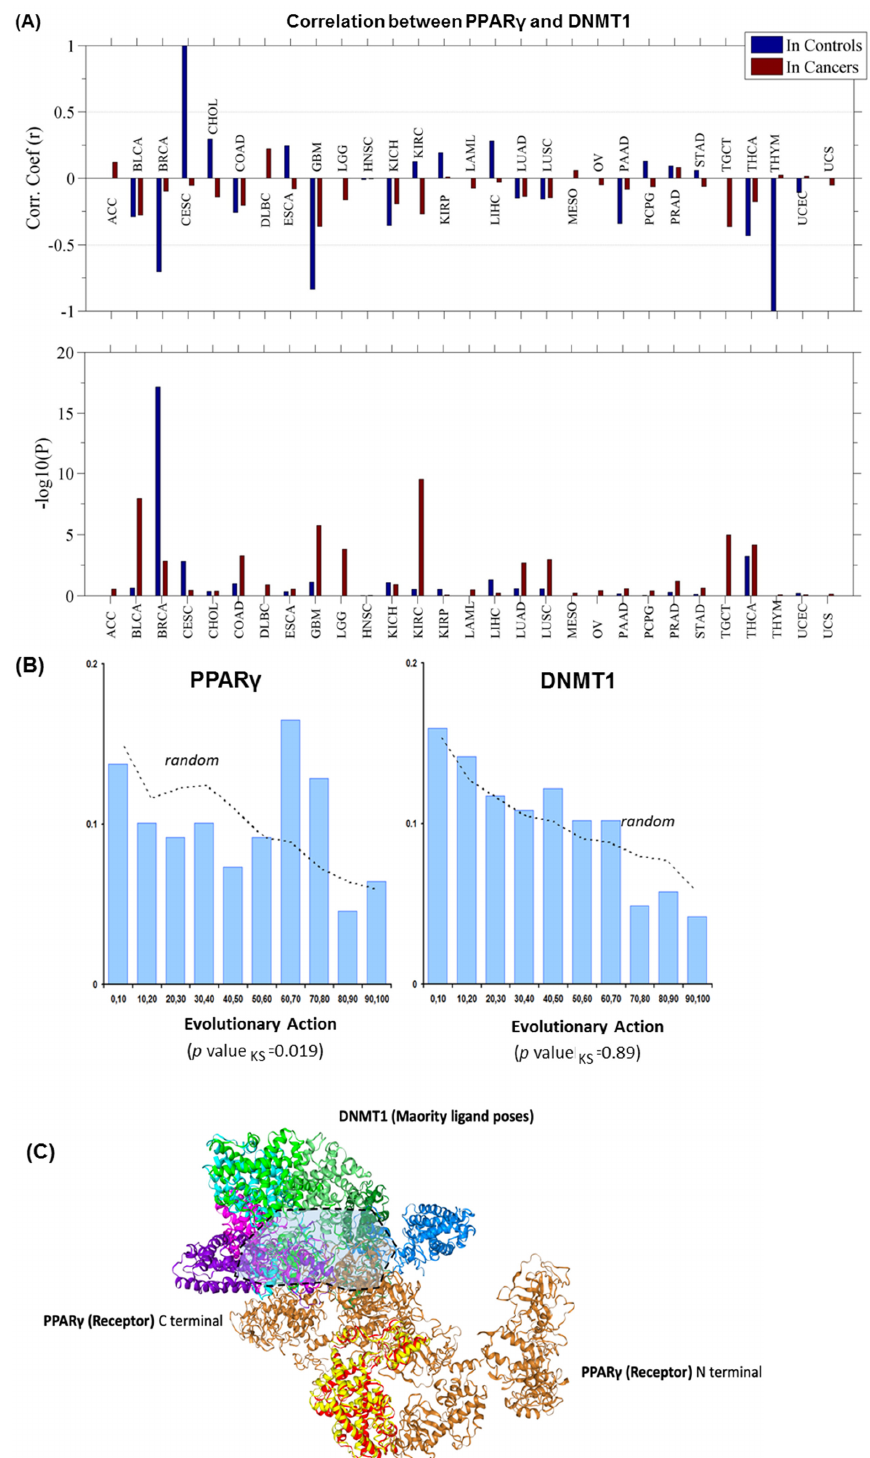
Figure 3. PPAR γ –DNMT1 protein–protein interactions and cancer landscape. ( A ) The Pearson correlation coefficient (r) of expression between PPAR γ and DNMT1. Top panel, the coefficients in control samples and cancer samples, respectively; Bottom panel, the significance ( p -value (-log10)) of each coefficient by t-test: ( B ) Evolutionary action (EA) scores showing significance levels. ( C ) High scoring docking poses from the docking simulation for PPAR γ –DNMT1 proteins. In the docking simulation PPAR γ (camel colored) is shown as receptor, DNMT1 (several colors for different docking po- sitions) as ligand and protein backbone in ribbon format. The highly probable interface is depicted with a shaded region.